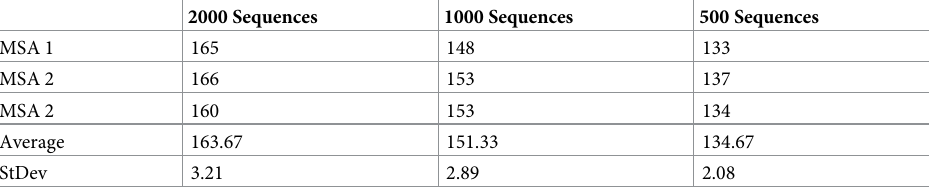
Table 1. Comparison of wildtype MSA to subsets of varying